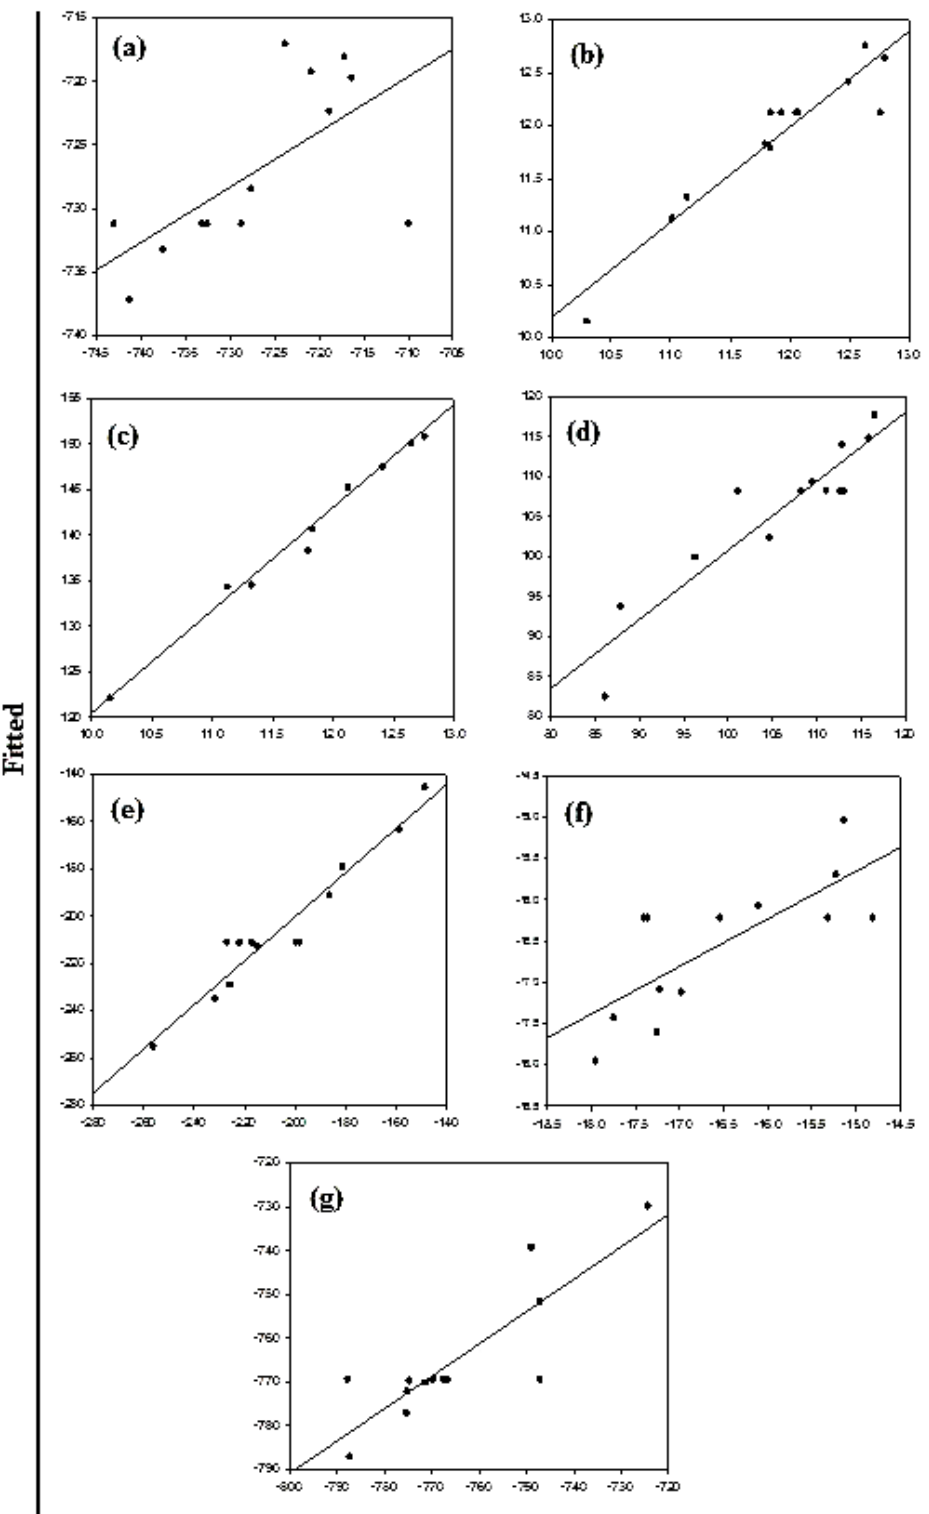
Figure 9. Linear correlation plots between fitted and actual values for ( a ) total steric energy; ( b ) bond length contributions; ( c ) bond angle contributions; ( d ) dihedral torsional contribution; ( e ) Van der Waals interactions; ( f ) h ydrogen-bond energy function and ( g ) electrostatic